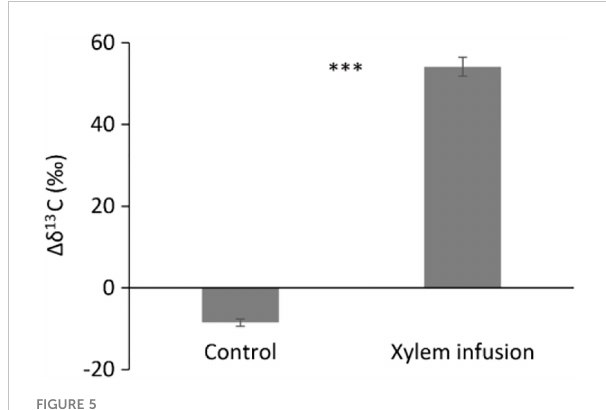
FIGURE 5 Carbon isotopic composition ( d 13 C) in shoot dark respirated CO 2 in non-treated Acer pseudoplatanus young trees (controls) and trees xylem-infused with 13 C-labelled glucose ( n = 3, mean value ± 1 SE). Dd 13 C ( ‰ ) = shoot dark respirated d 13 C ( ‰ ) minus the ambient air d 13 C ( ‰ ). *** (P < 0.001) denote signi fi cant differences in Dd 13C values between xylem infusion and